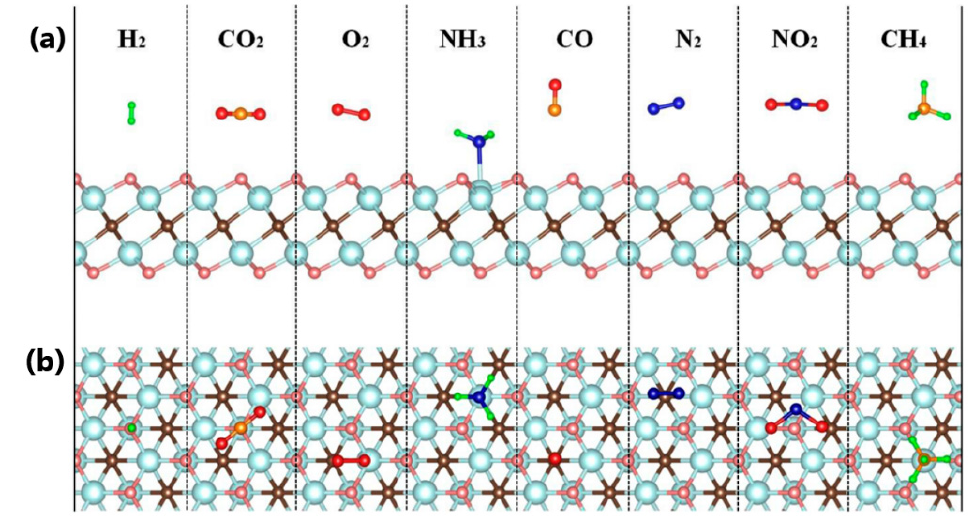
Figure 10. Schematic illustration of the gas adsorption on the Ti 2 CO 2 monolayer: ( a ) side view; ( b ) top view. Reprinted with permission from [79]. Copyright © 2015, American Chemical Society.